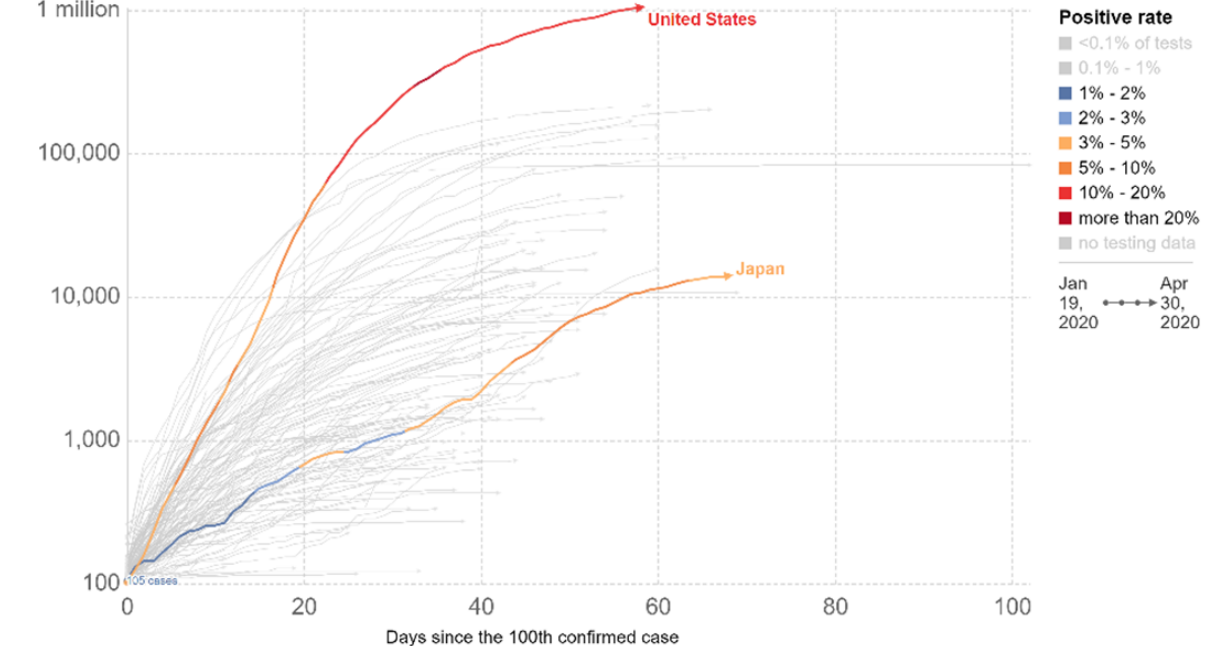
Figure 5. COVID-19 epidemic curves for the United States and Japan through May 1, 2020 [26]. The plot shows cumulative confirmed COVID-19 cases. The number of confirmed cases is lower than the number of actual cases; the main reason for that is limited testing. The source of this data is the European Centre for Disease Prevention and Control, Situation Update Worldwide, last updated August 31, 2020, 10:34 AM (London time). Official data were collated by Our World in Data